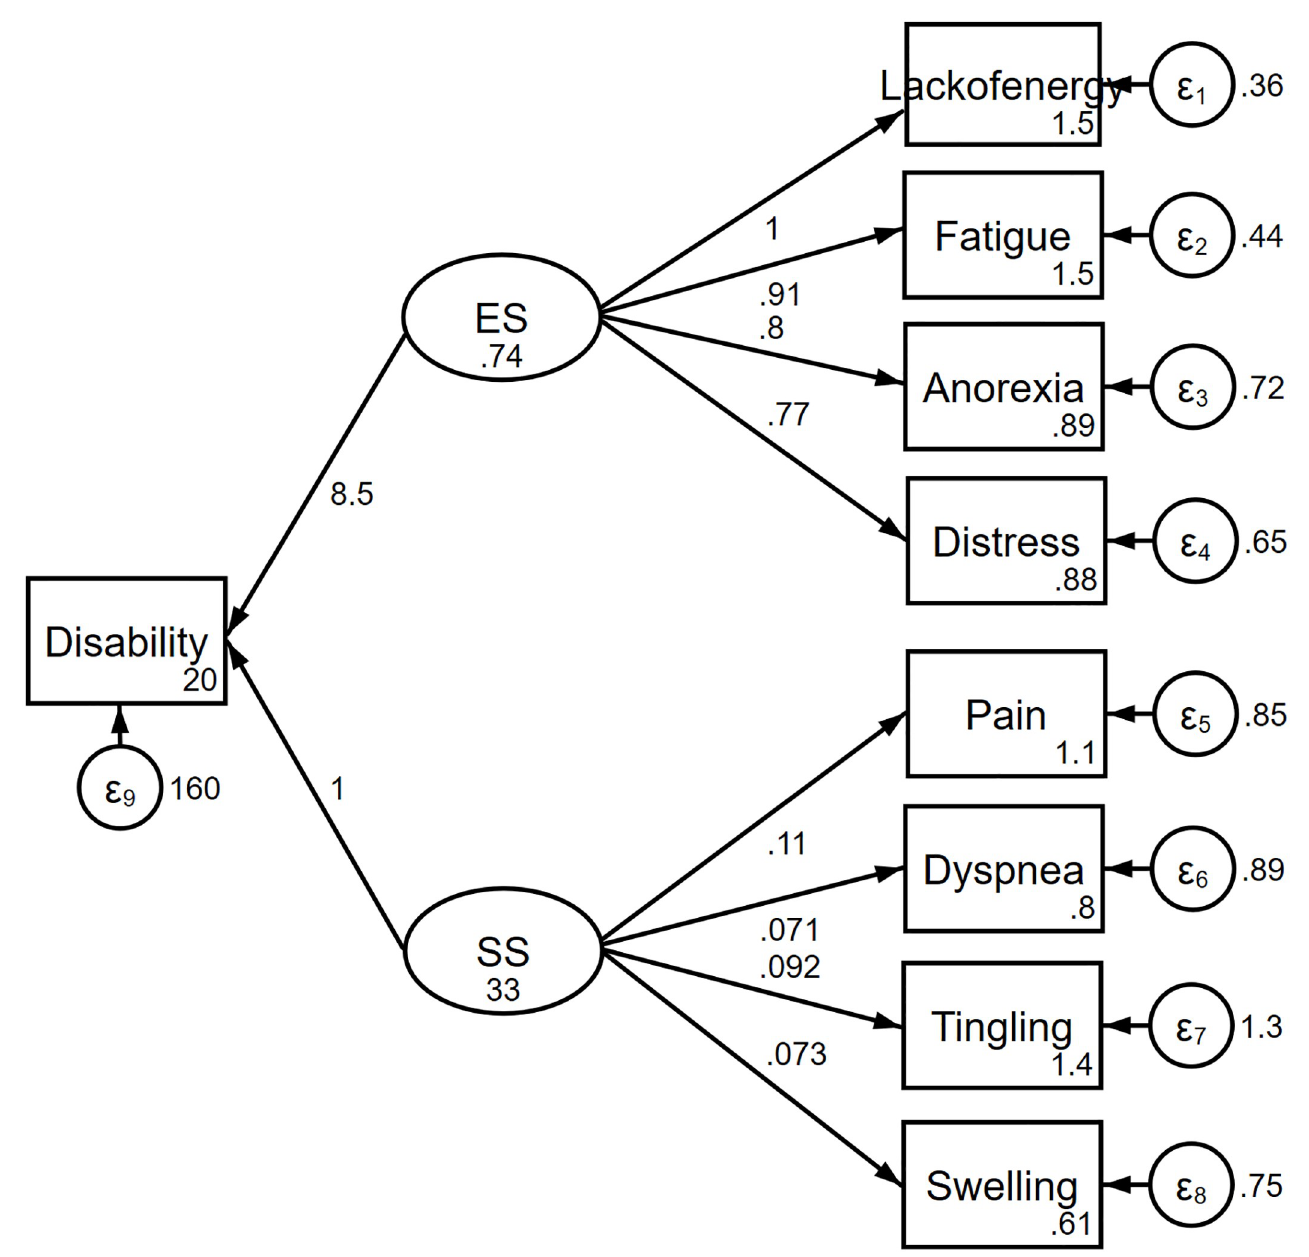
Fig 2. Two-factor model of the relationship between symptoms and disability. ES, experienced symptoms; SS, somatic sensation.